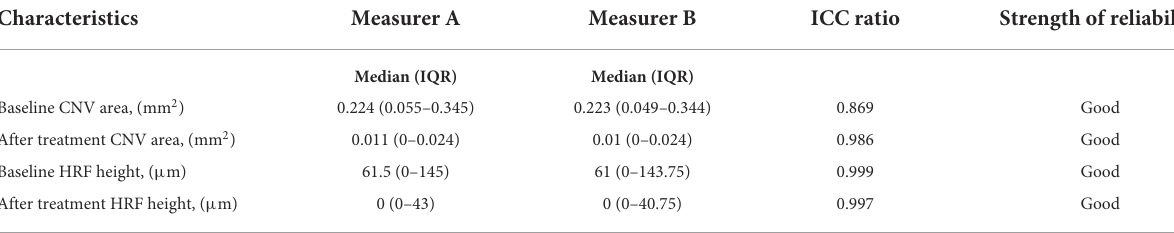
TABLE 1 Between measurers reliability regarding the CNV area and HRF